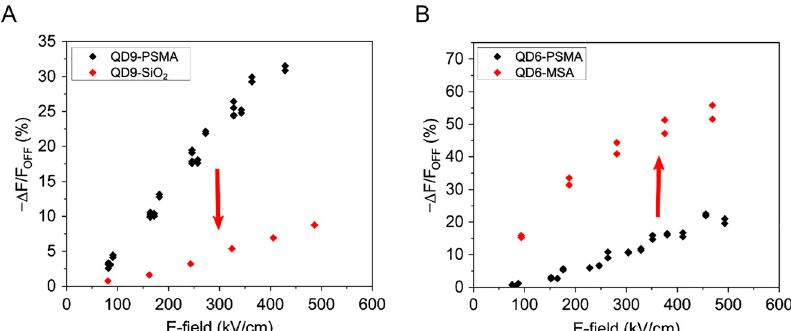
Figure3: Δ F / F OFF asafunctionofelectric fi eld under1Pexcitation(460 – 495nm)for(A)the quasi-type-II QD9-PSMA (black) and QD9- SiO 2 (red) and for (B) the type-I QD6-PSMA (black) and QD6-MSA (red).